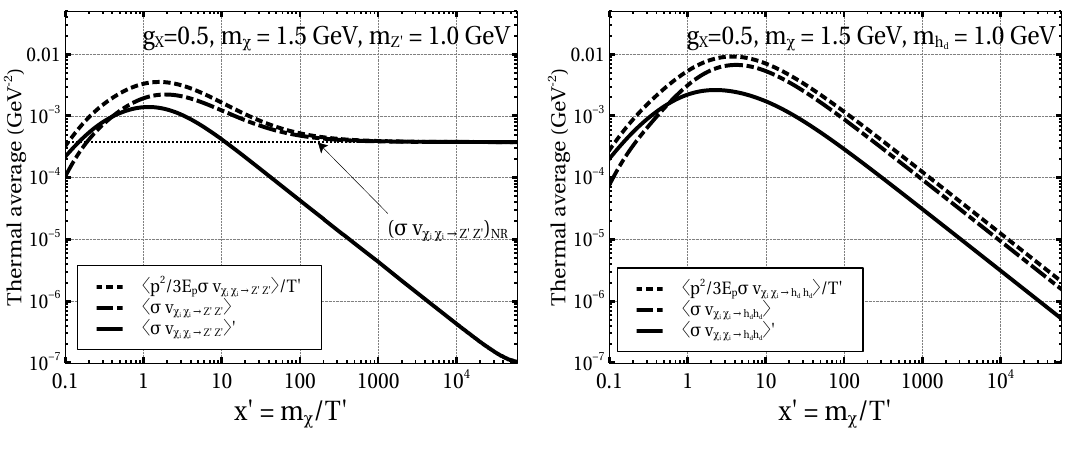
Figure 3 . Behaviour of 1 h p 2 σ v i (dotted line), h σ v i (dash-dotted line), and h σ v i 0 (solid line) T 0 3 E p with x 0 for a s-wave (left panel) and a p-wave annihilation